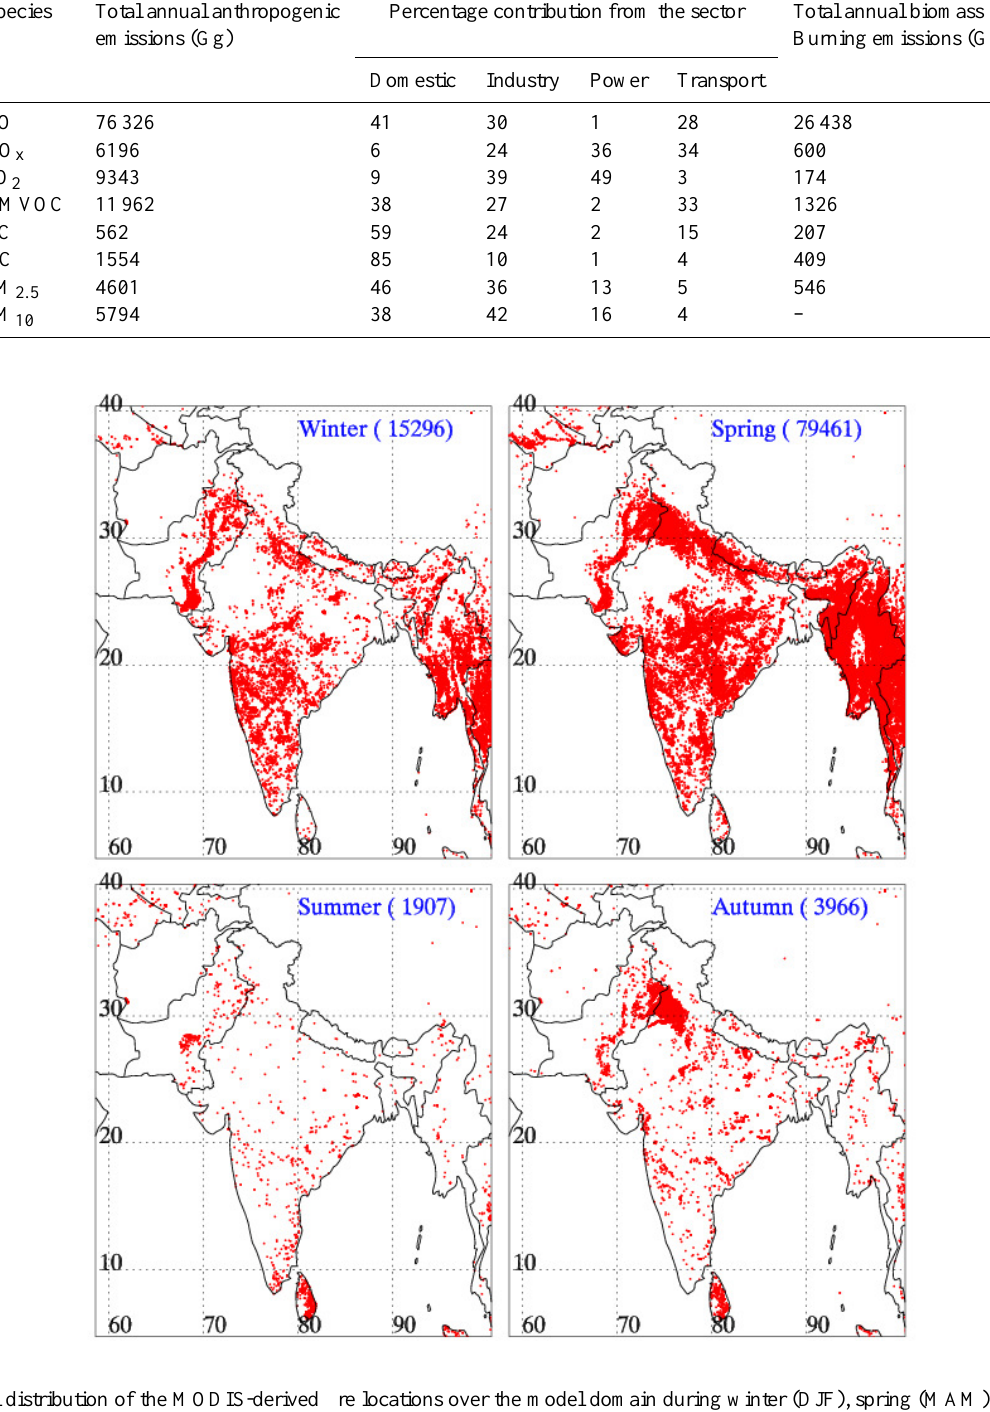
Fig. 3. Spatial distribution of the MODIS-derived fire locations over the model domain during winter (DJF), spring (MAM), summer (JJA) and autumn (SON) of the year 2008. These fire locations are used in FINN for estimating the biomass burning emissions. Numbers in the parenthesis denote total fire counts in each season.